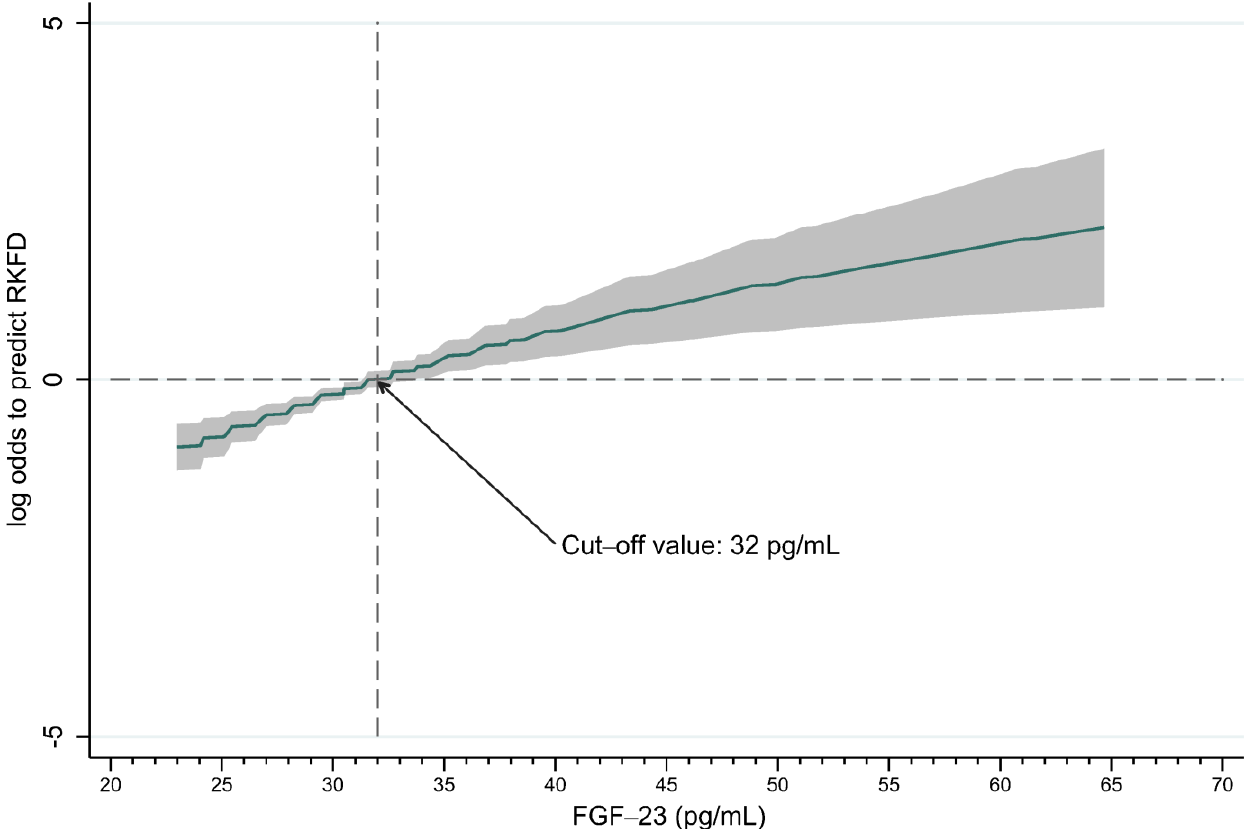
Figure 4. Generalized additive model plot for the FGF-23 (cut-off value: 32 pg/mL) against the probability of RKFD (adjusted with eGFRcr-cys, UACR, age, gender, metabolic syndrome, total cholesterol, LDL).